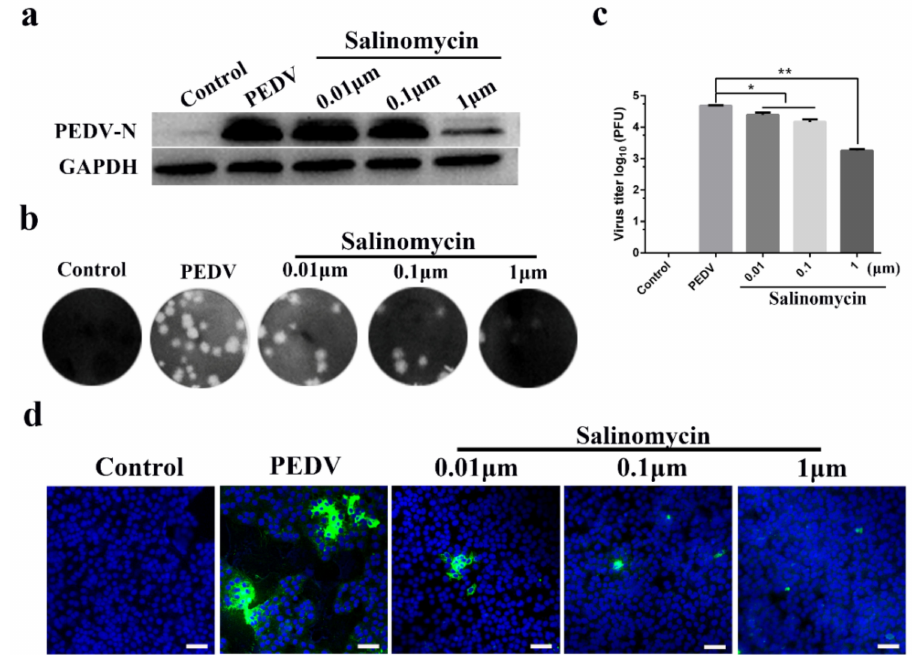
Figure 2. Antiviral activity of salinomycin on porcine epidemic diarrhea virus (PEDV) infection in Vero cells. Vero cells mock pretreated with DMSO or pretreated with salinomycin at concentration of 0.01, 0.1 and 1 µ M, respectively. These cells were subjected to PEDV infection for 1 h with or without salinomycin treatment. After extensive washing using PBS, cells were further cultured for 24 h with the medium containing salinomycin or blank medium. Viral yields were then titrated by ( a ) western blot, ( b ) plaque assays and ( d ) indirect immunofluorescence assay (IFA). Green: PEDV N protein; Blue: DAPI; Scale bar, 20 µ m. ( c ) Statistical of plaque assays results. The assays were performed in duplicate and data present as means ± SD. * p < 0.05, ** p < 0.01.